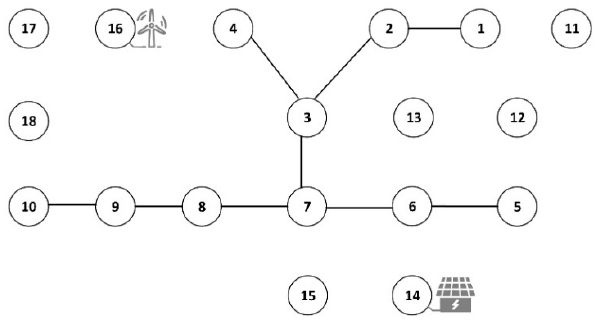
Figure 4. Garver-18 testing system.